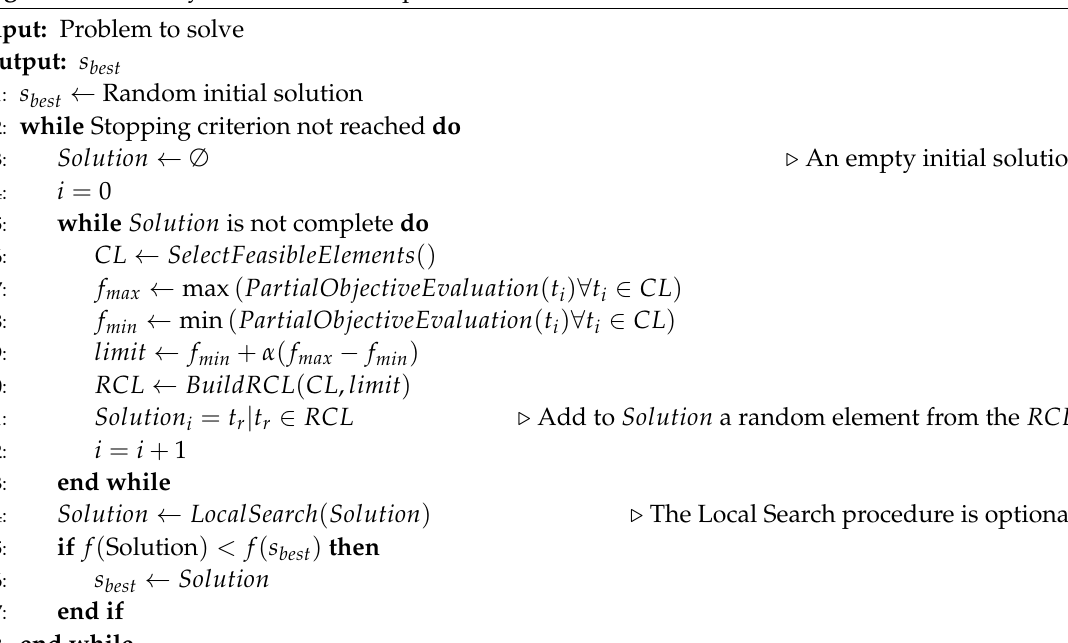
Algorithm 3 Greedy Randomized Adaptive Search